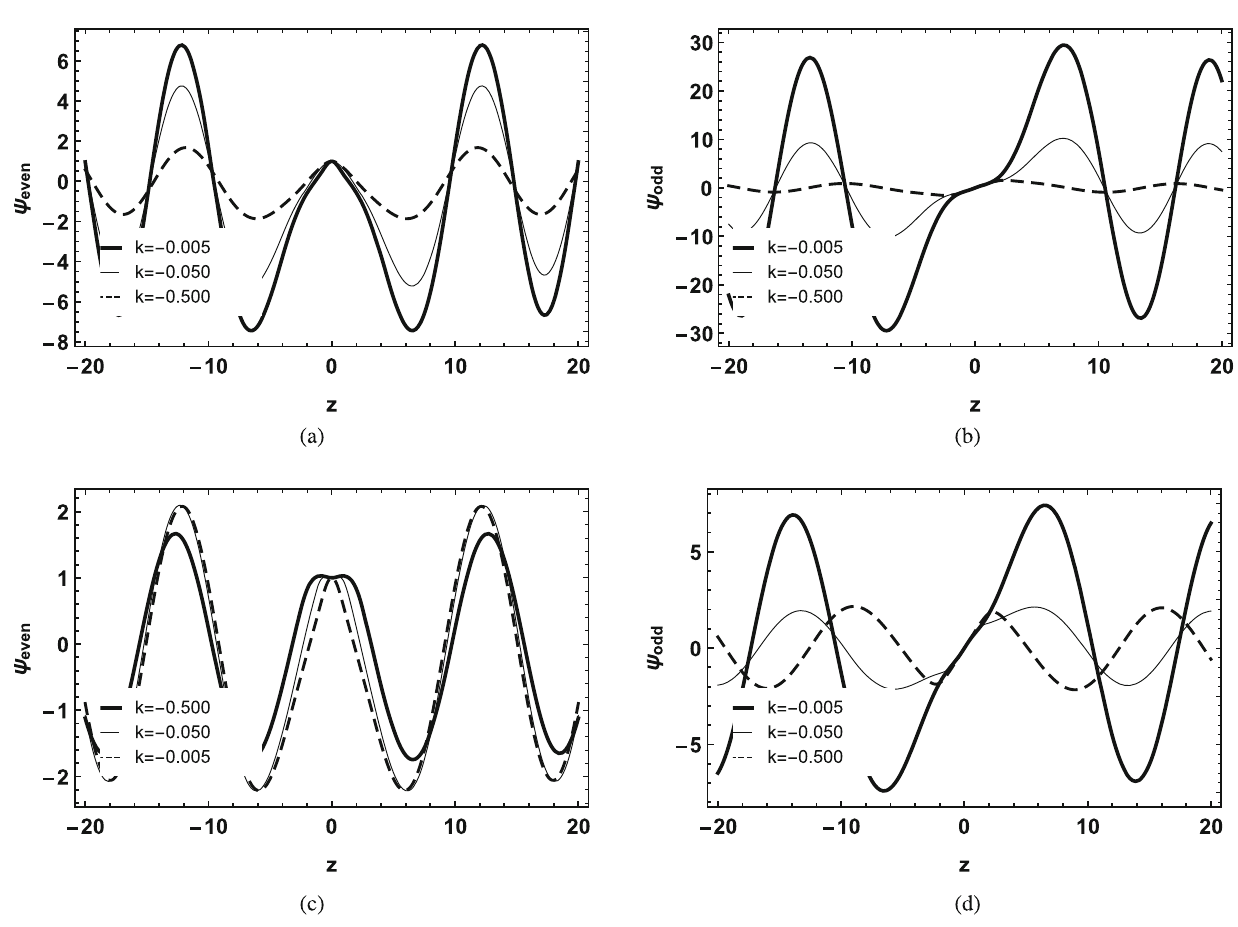
Fig. 18 The behavior of massive modes for G 2 ( T ) , with n = 2 and p = λ = 1. To the Gauge field, a ψ e v en with m = 0 . 652. b ψ odd with m = 0 . 593. KR field, c ψ e v en with m = 0 . 556. d ψ odd with m = 0 .